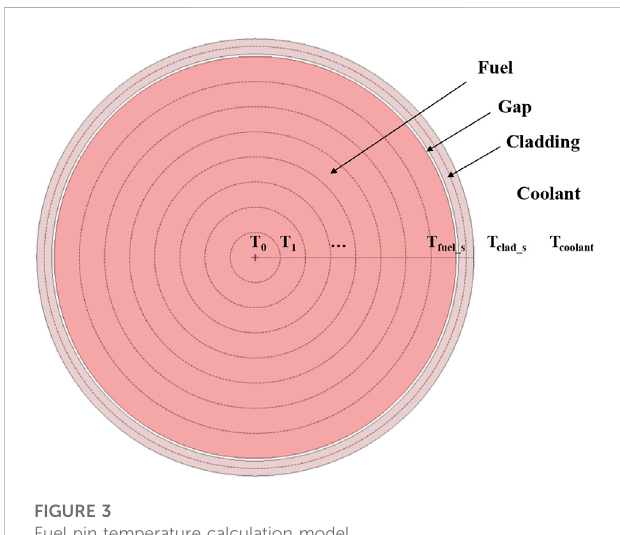
FIGURE 3 Fuel pin temperature calculation